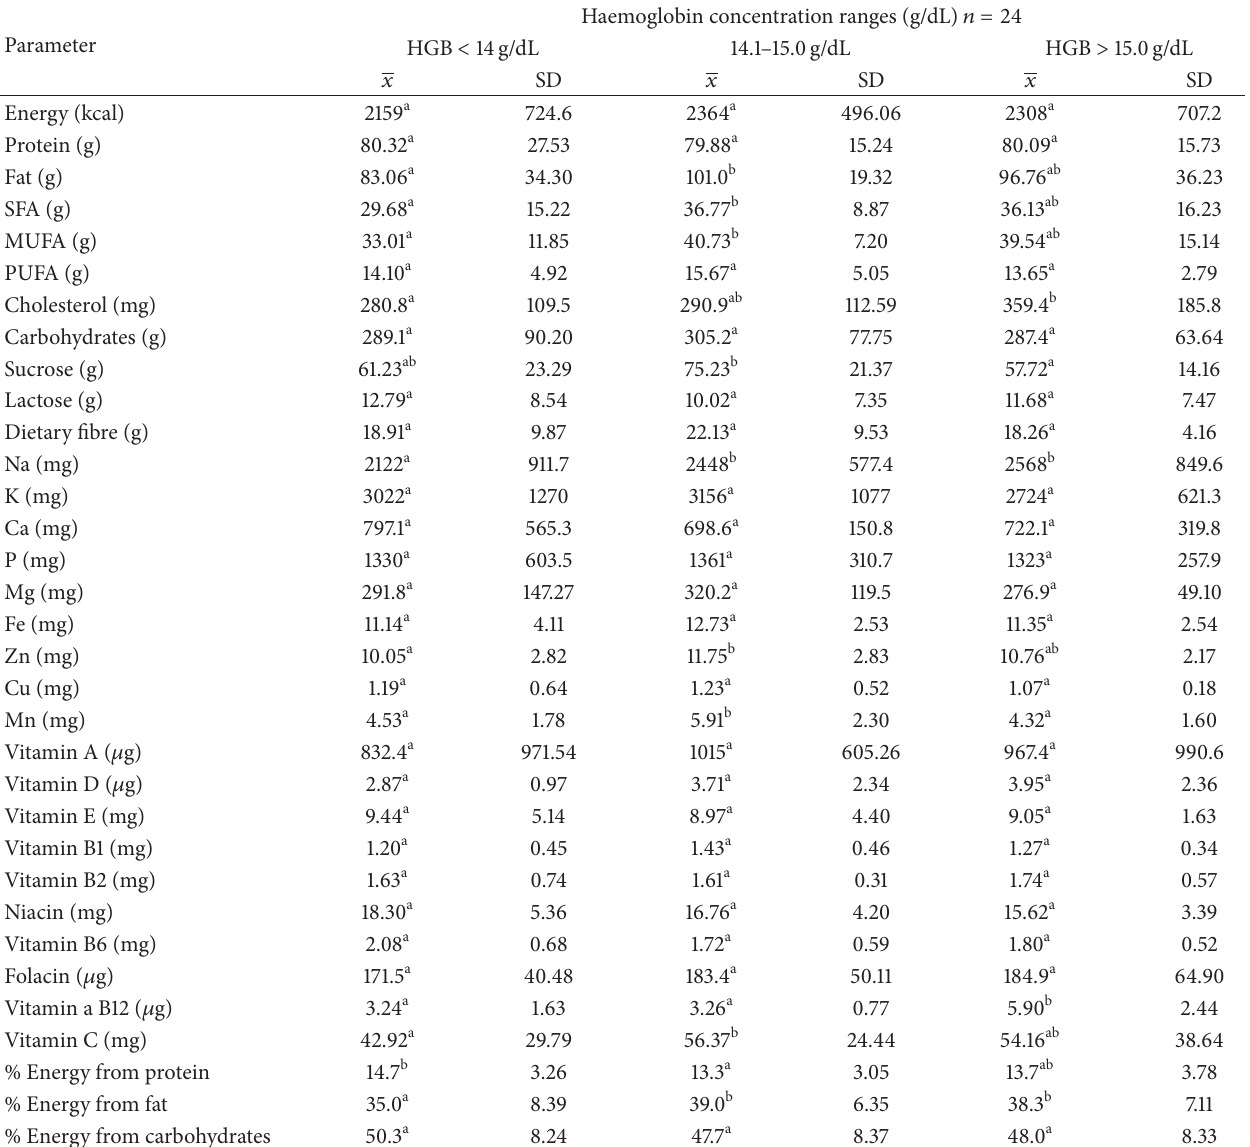
Table 3: Men’s DFR composition with respect to haemoglobin concentration in